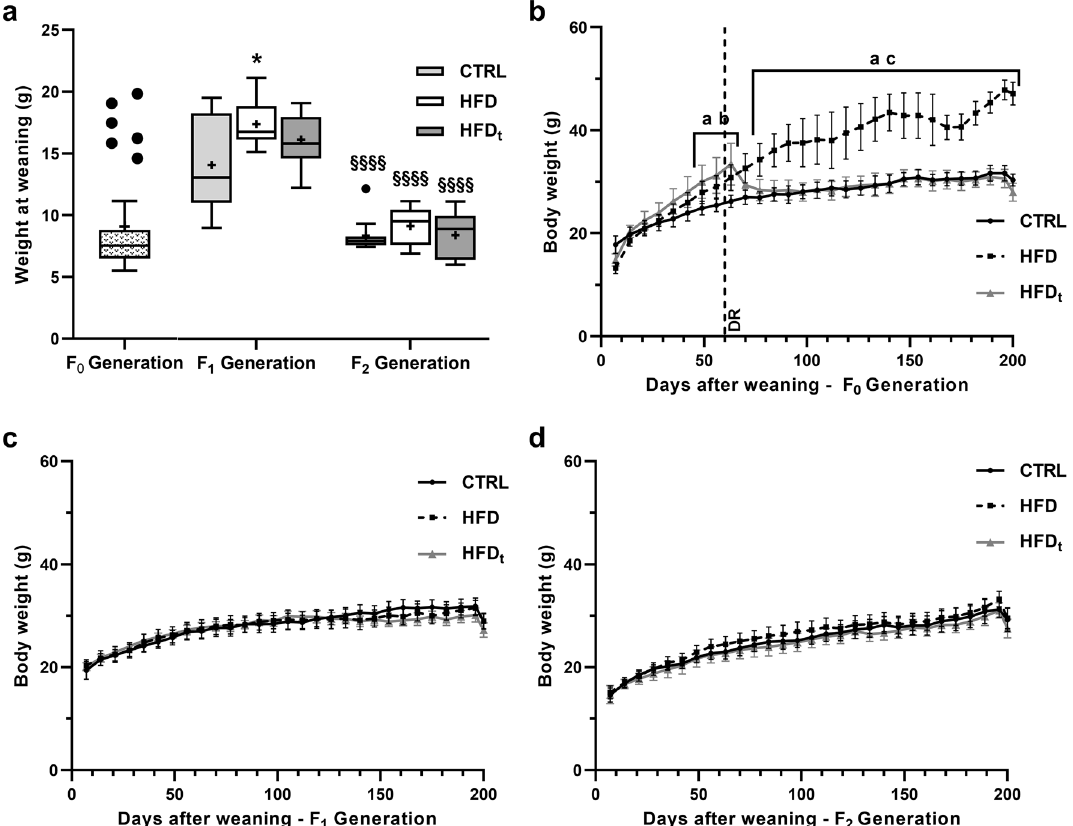
Figure 1. The evolution of body mass from weaning to sacrifice, across generations. ( a ) Body weight at weaning (g), expressed as Tukey’s whisker boxes (median, 25th to 75th percentiles ± 1.5 interquartile range). Mice of F 0 Generation were weighted and then randomly assigned to an experimental group (n = 12 per group in each generation). Data was tested by one-way ANOVA with Tukey’s HSD for group comparison within the same generation. Two-way ANOVA with Šidak correction was used to compare each diet group in Generation F 1 against its F 2 counterparts. Significance was considered when p < 0.05. * vs. CTRL; # vs. HFD; § vs. Generation F 1 . Multiple significance signs represent different significance levels: *p < 0.05; **p < 0.01; ***p < 0.001; ****p < 0.0001; filled circle Extreme values; + Group mean. Body weight curves for ( b ) F0 Generation, ( c ) F 1 Generation and ( d ) F 2 Generation were obtained by monitoring the mice weight weekly (12 mice per group in each generation). Results are expressed as the mean body weight (g), with whiskers representing the 95% Confidence Interval. The main and simple effects between groups were tested by Repeated Measures ANOVA corrected for family-wise comparisons using the Šidak method, and by Greenhouse–Geisser correction for sphericity. Graphs were obtained using the software GraphPad Prism 8 (San Diego, CA, USA). Significance was considered when p < 0.05. a—CTRL vs. HFD; b—CTRL vs. HFD t ; c—HFD vs. HFD t . DR diet